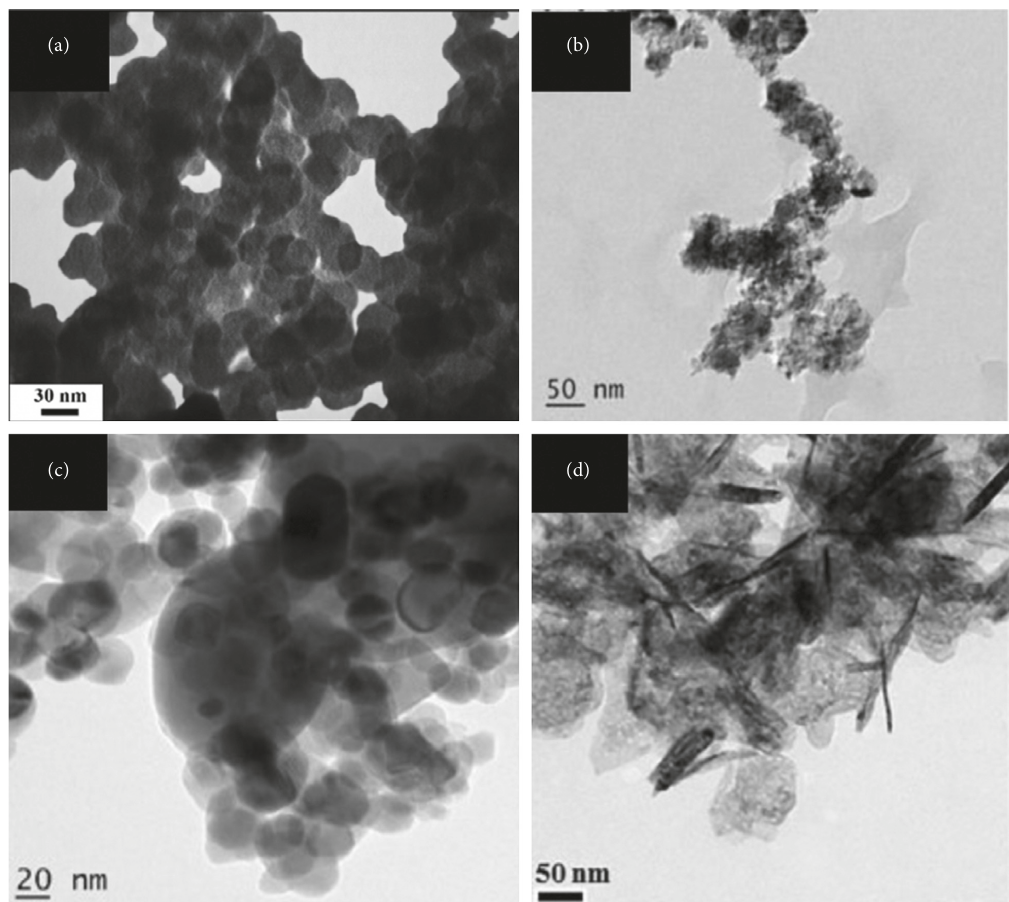
Figure 8: TEM images of (a) Sm 2 O 3 NPs [166], (b) CeO 2 NPs [175], (c) La 2 O 3 NPs [187], and (d) Y 2 O 3 NPs